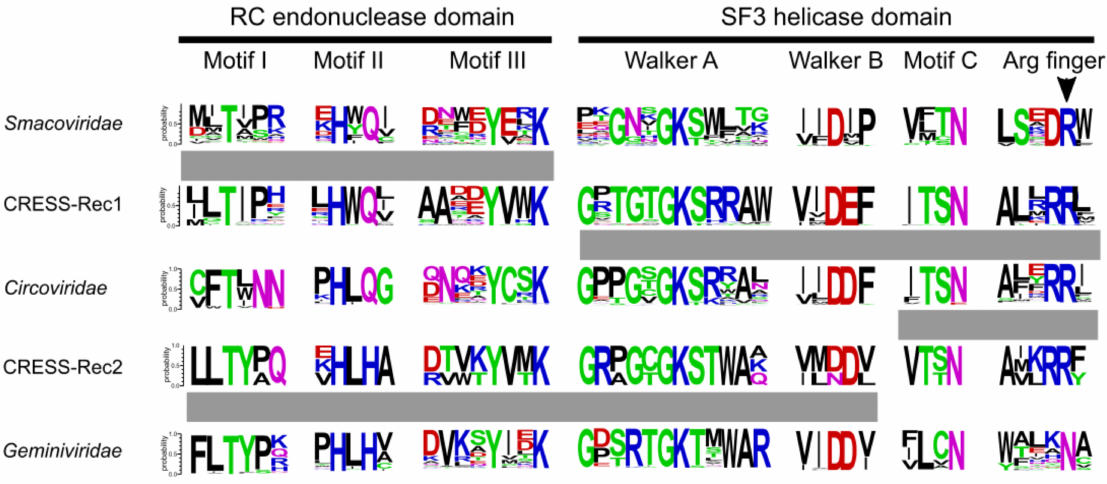
Figure 2. Sequence motifs of Rep proteins from classified and possibly recombinant CRESS DNA viruses. Motifs are presented as sequence logos and those containing predicted recombinations are joined with grey rectangles. Residues are colored according to their chemical properties (polar, green; basic, blue; acidic, red; hydrophobic, black; neutral,